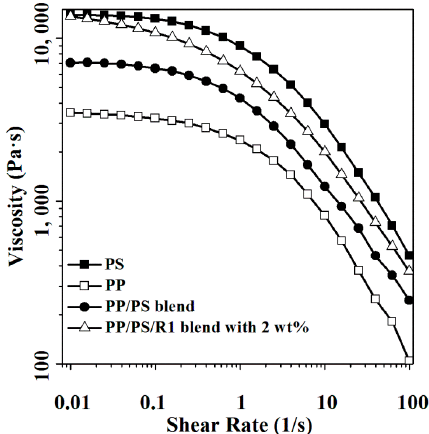
Figure 8. Rheological behaviors of PP, PS, and binary PP/PS (80/20) and the ternary blend with 2 wt% of P1.